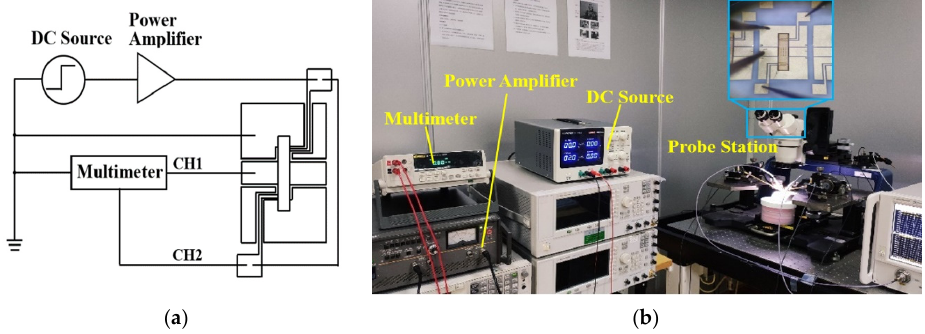
Figure 8. ( a ) Test circuit diagram for the driving voltage. ( b ) Test platform for the driving voltage.